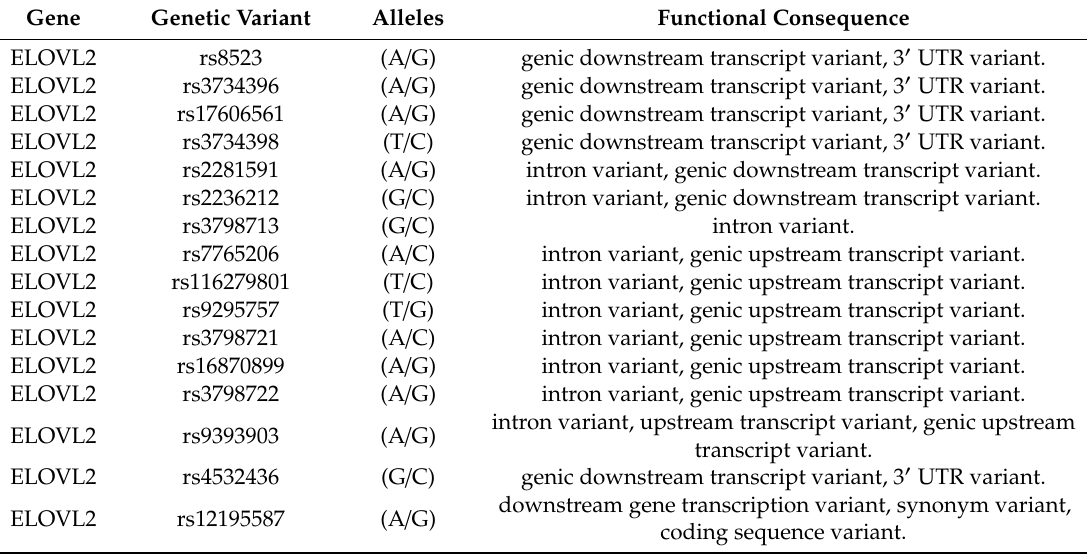
Table 1. Genetic markers